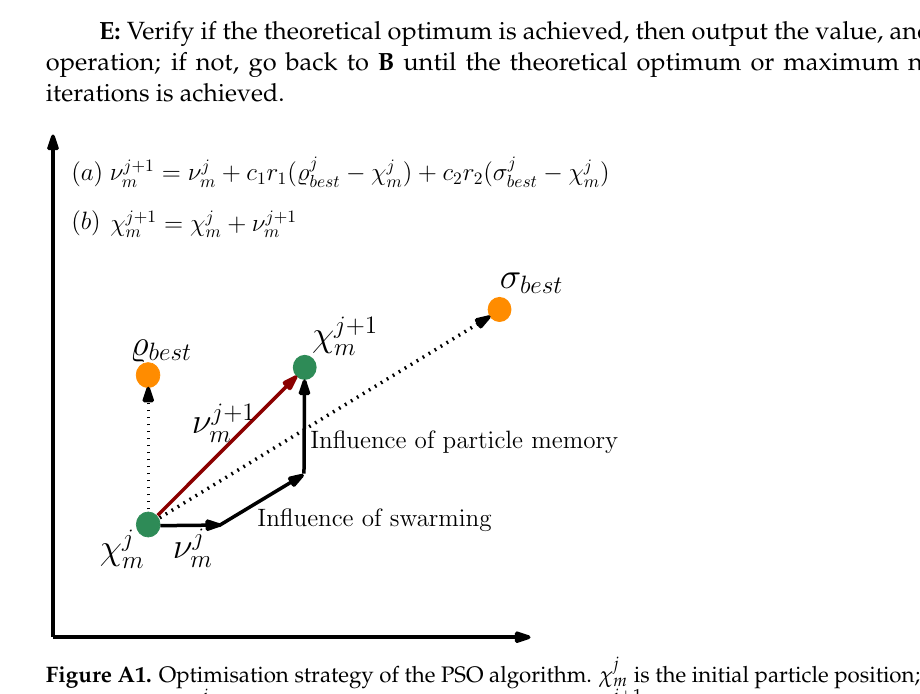
Figure A1. Optimisation strategy of the PSO algorithm. χ j m is the initial particle position; χ j new position; ν j m is the current velocity of the particle; ν j different aspects (influence of the particle and swarm